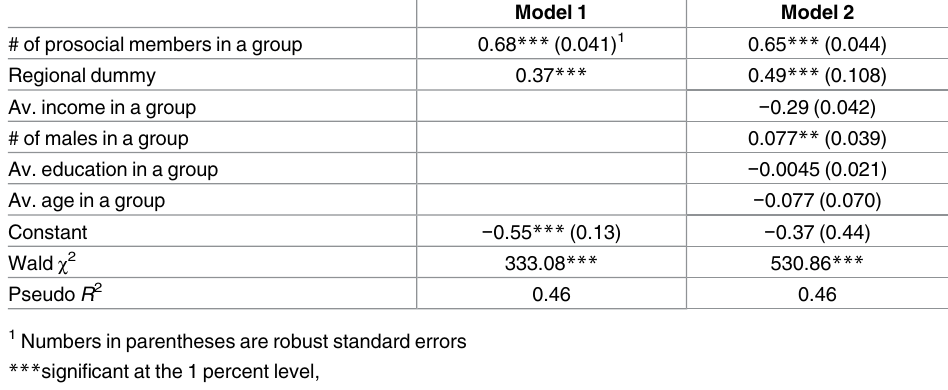
Table 3. Poisson regression for the terminal periods in the dynamic CPR